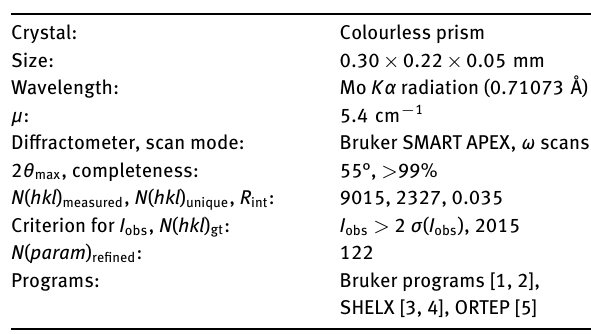
Table 1: Data collection and handling.